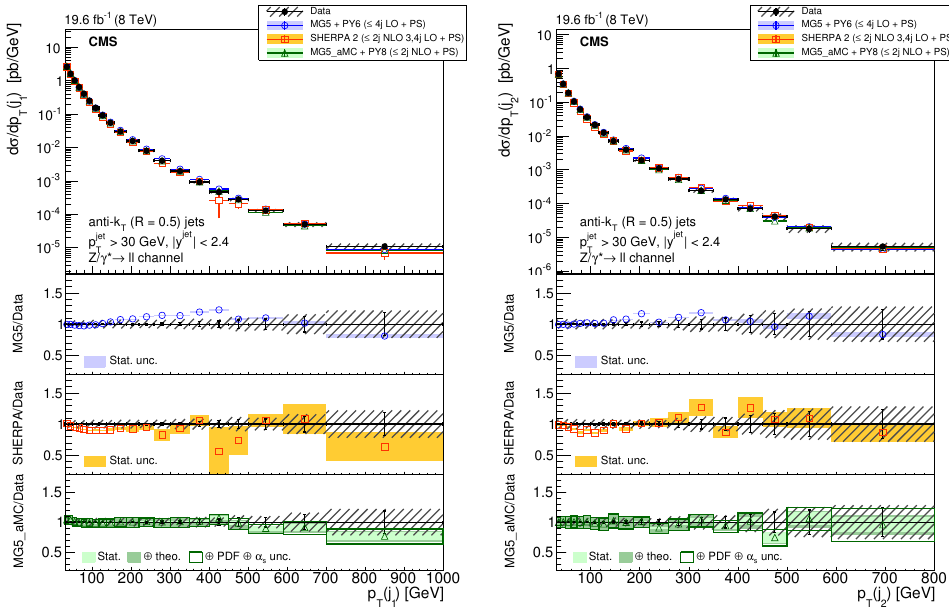
Figure 3 . The di(cid:11)erential cross section for Z ( ! ‘‘ ) + jets production measured as a function of the (left) 1 st and (right) 2 nd jet p T compared to the predictions calculated with MadGraph 5 + pythia 6, sherpa 2, and mg5 a mc + pythia 8. The lower panels show the ratios of the theoretical predictions to the measurements. Error bars around the experimental points show the statistical uncertainty, while the cross-hatched bands indicate the statistical and systematic uncertainties added in quadrature. The boxes around the mg5 a mc + pythia 8 to measurement ratio represent the uncertainty on the prediction, including statistical, theoretical (from scale variations), and PDF uncertainties. The dark green area represents the statistical and theoretical uncertainties only, while the light green area represents the statistical uncertainty